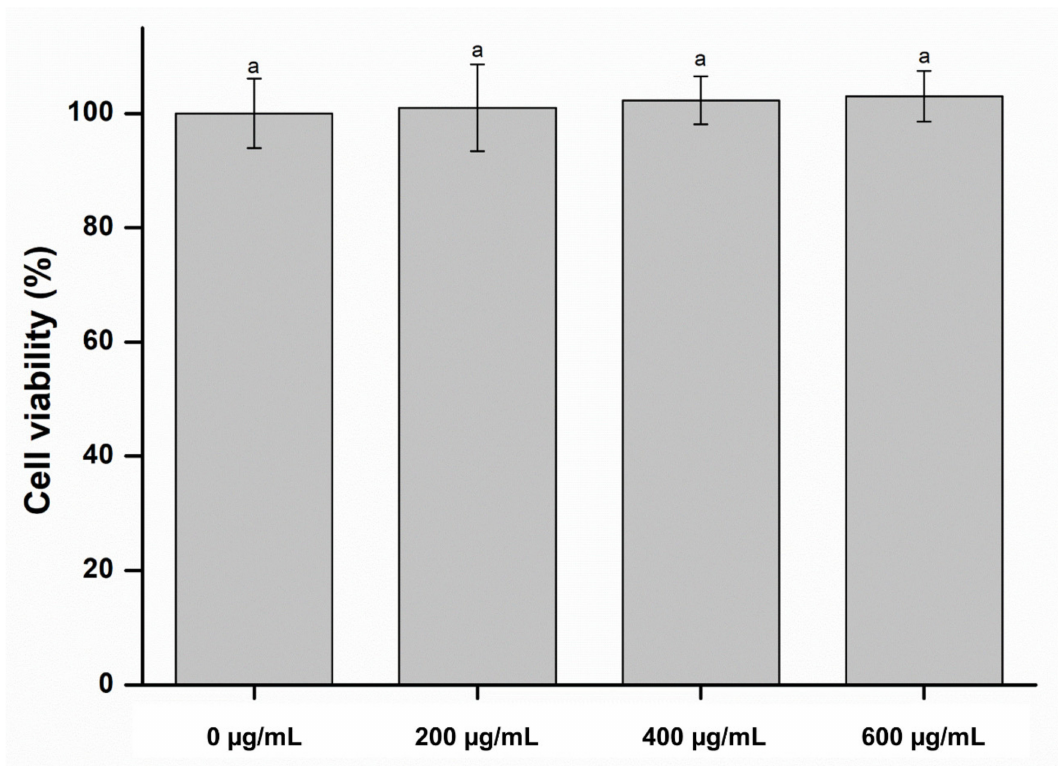
Figure 3. Cell viability of the experimental and control groups. Each value represents the mean of five measurements, and error bar shows the standard deviation of the mean. The lowercase letter indicates that there were no significant differences between the values of the experimental and control groups ( p >